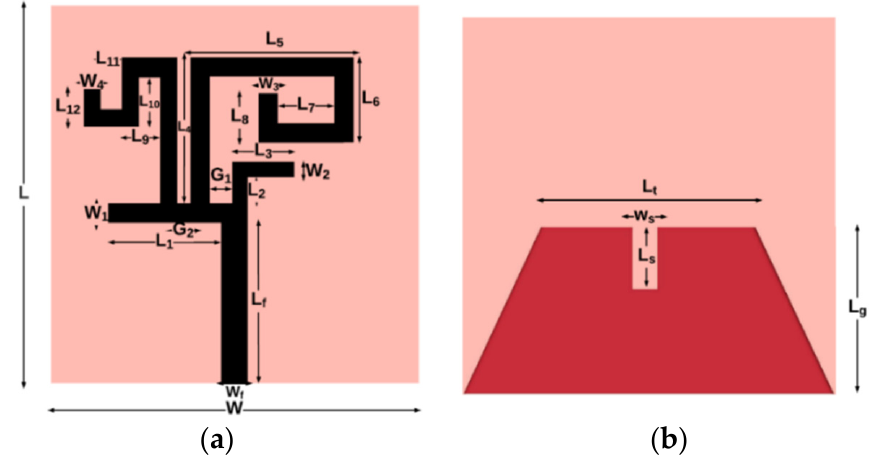
Figure 1. Proposed antenna element ( a ) front side (radiator), ( b ) back side (ground plane).